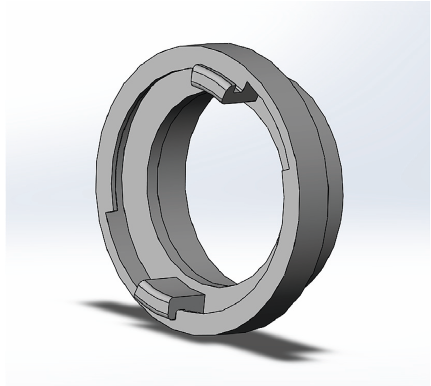
Figure 1: Three-dimensional view of the joint.